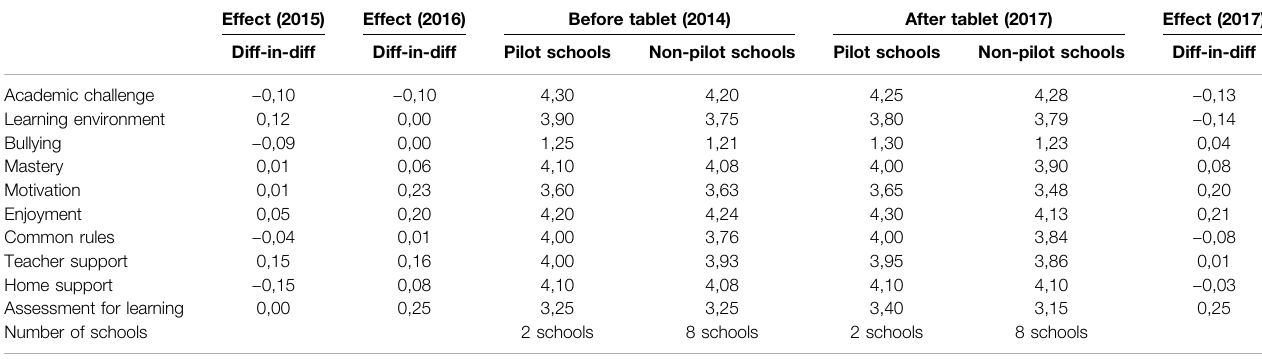
TABLE 12 | Difference-in-difference analysis of student survey indicators, 10th grade (group